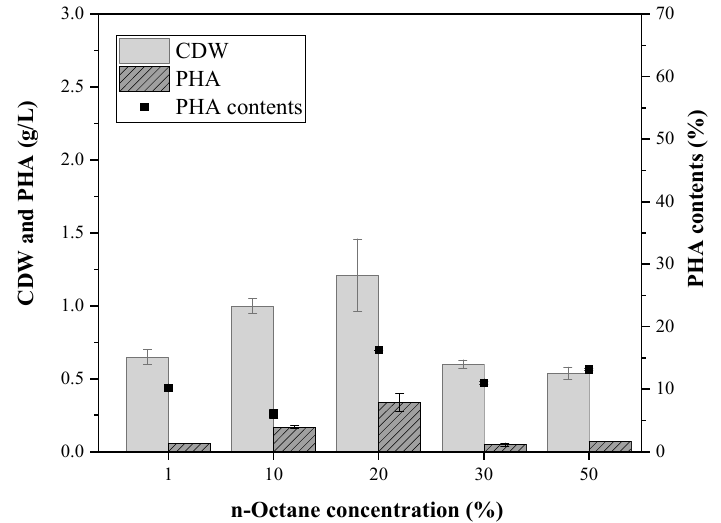
Figure 2. Cell growth and PHA production by P. resinovorans in the range of n-octane.